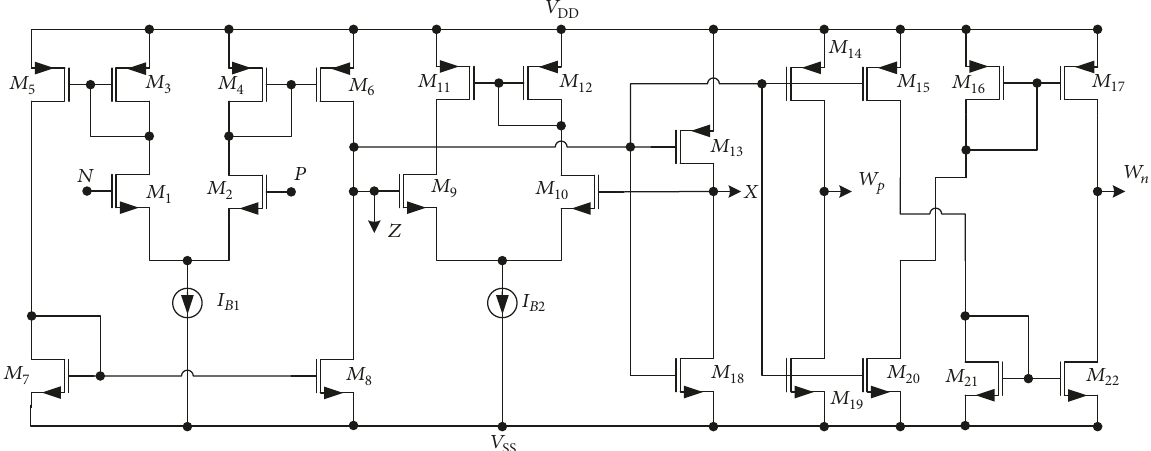
Figure 2: Internal construction of CMOS VDCC [10].